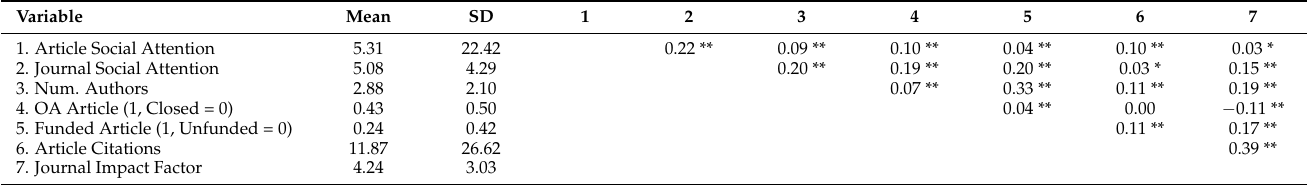
Table 4. Means, SDs, and Pearson correlations between the dependent and all independent